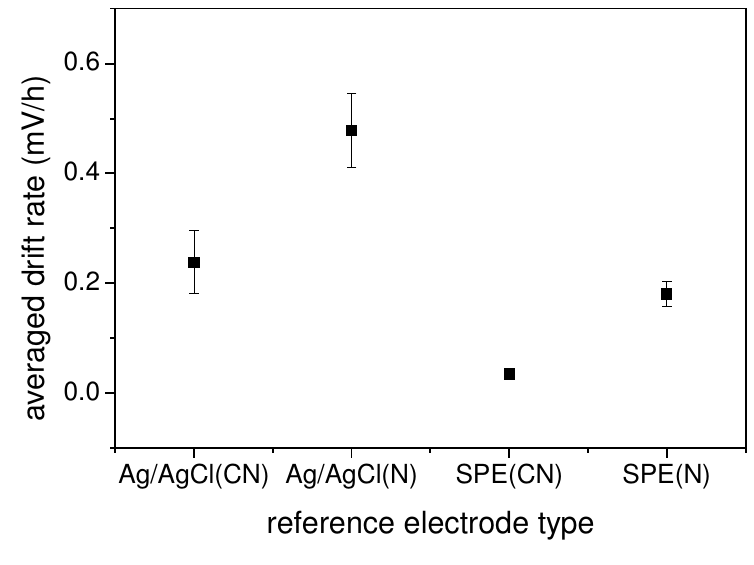
Figure 5. Averaged drift rate of different miniaturised reference electrodes with KCl-containing membrane and protective